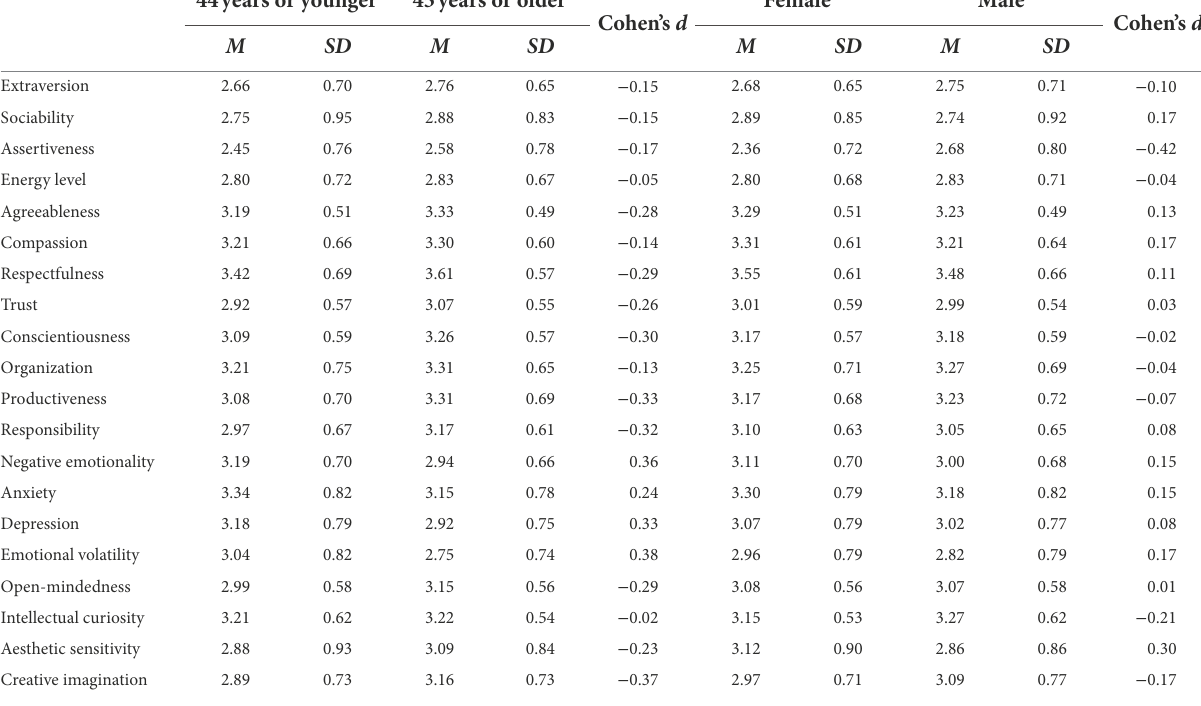
TABLE 9 Descriptive statistics at each age and sex